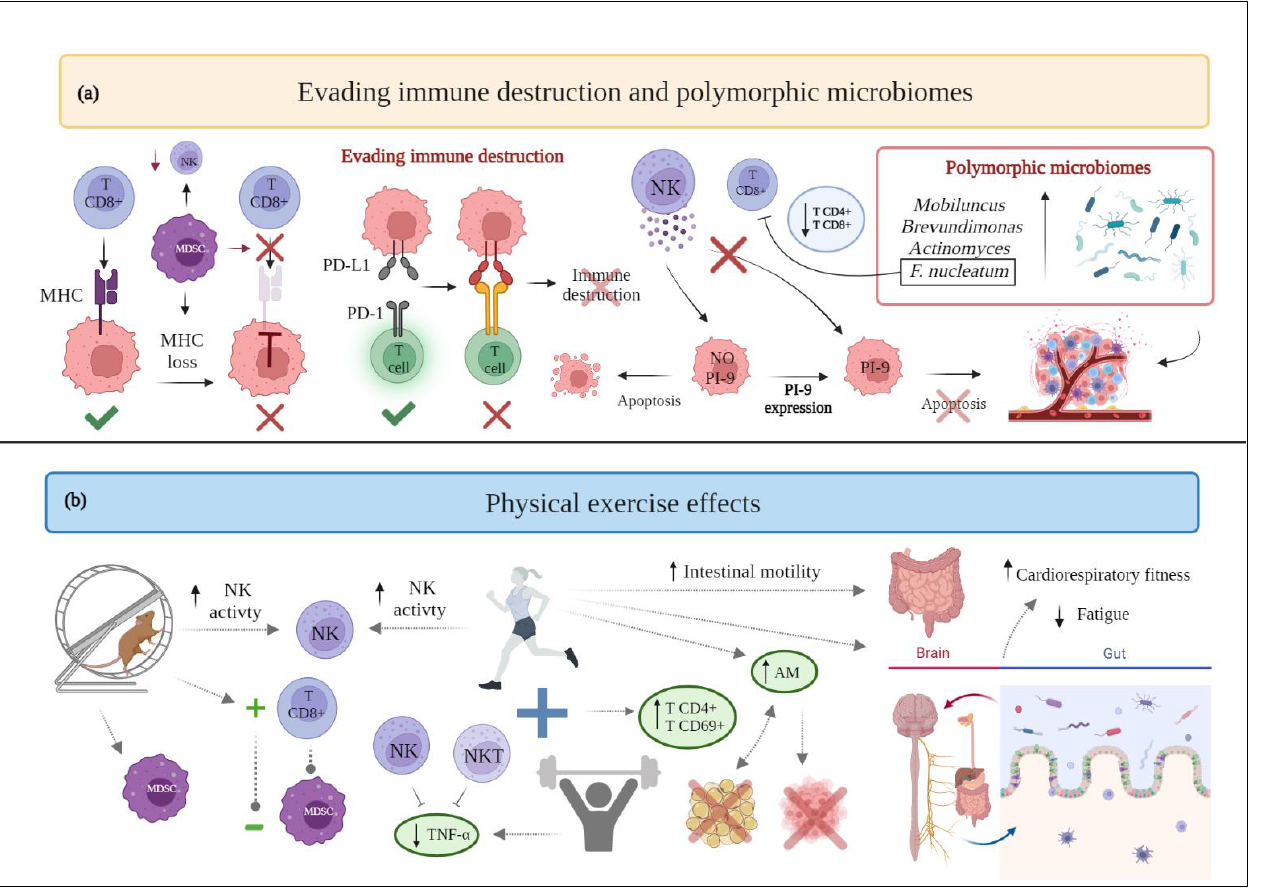
Figure 4. ( a ) Schematic drawing of cancer hallmarks, highlighting markers related to evading im- mune destruction and polymorphic microbiomes. ( b ) The effects of physical exercise on